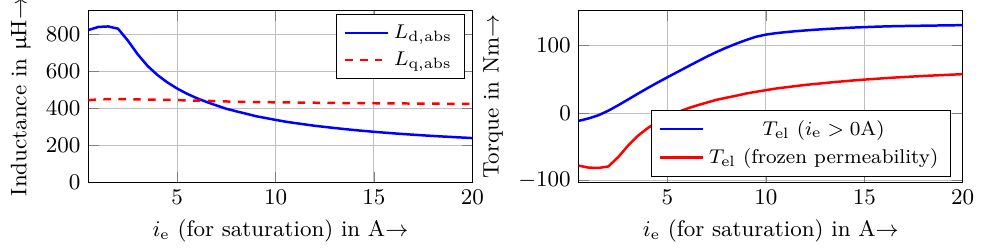
Figure 7. Inductances over excitation current i e determined with frozen permeability method. The bottom figure shows torque with and without excitation current. Stator current is set to i q = for all